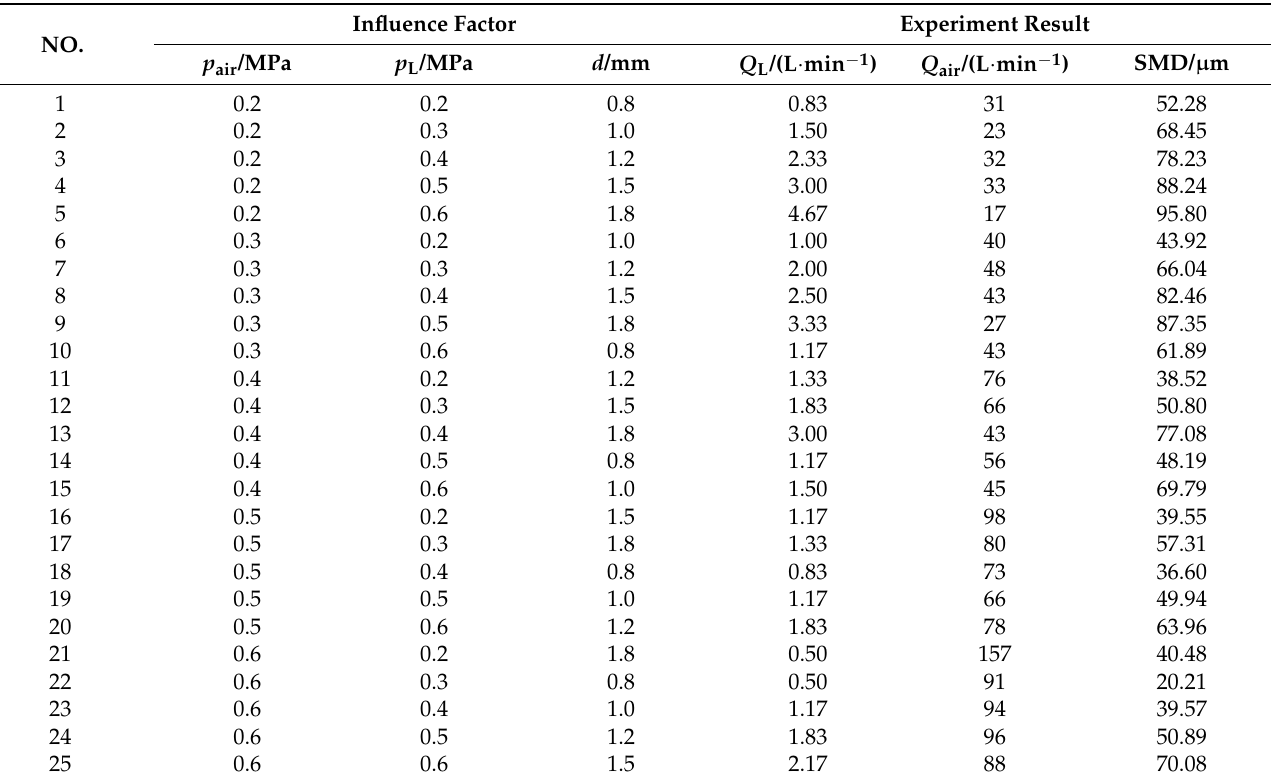
Table 2. Orthogonal experimental